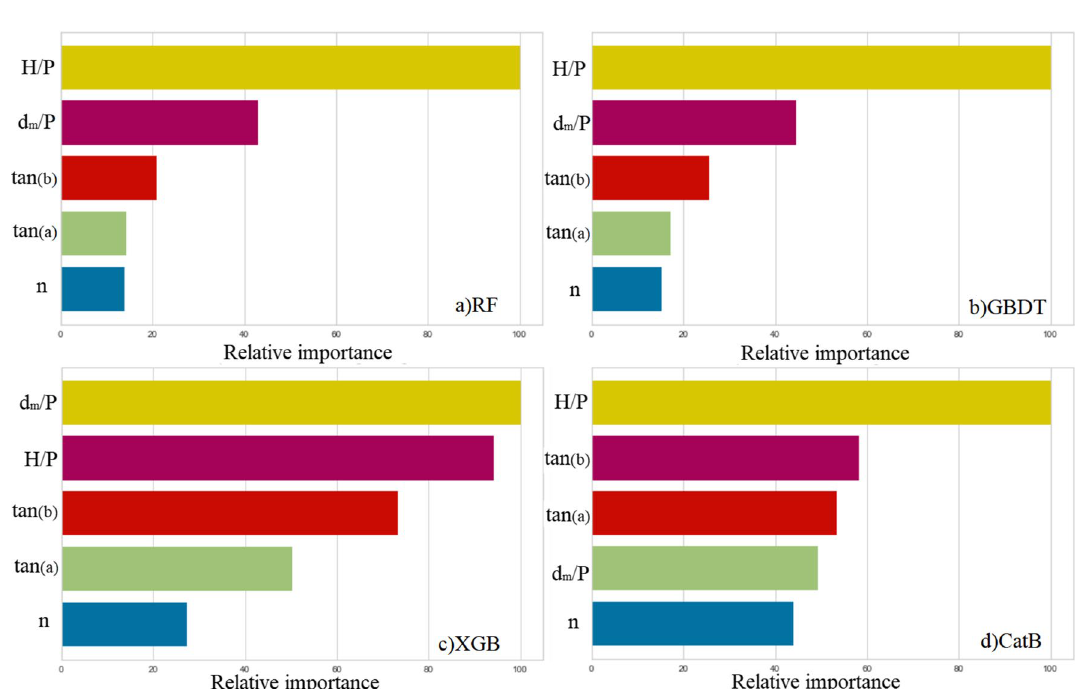
Fig. 8 Feature relative importance for estimation of C